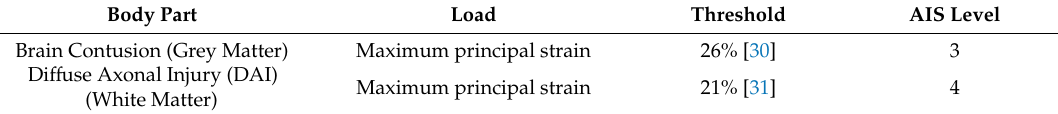
Table 2. White and grey brain matter maximum principal strain tolerance limits [30,31].